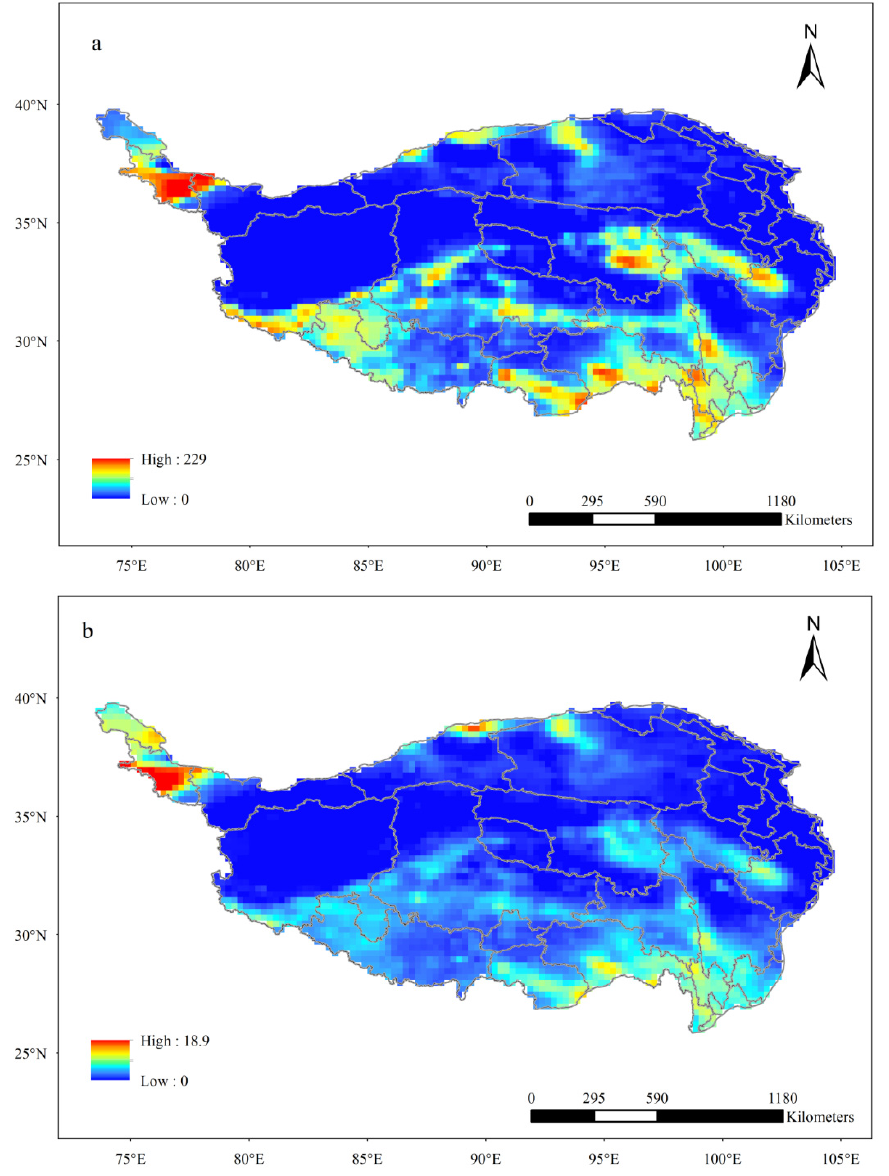
Figure 6. Spatial distribution of the average duration of snow disasters ( a ) and the average snow depth ( b ) on the QTP over the past 40 years.